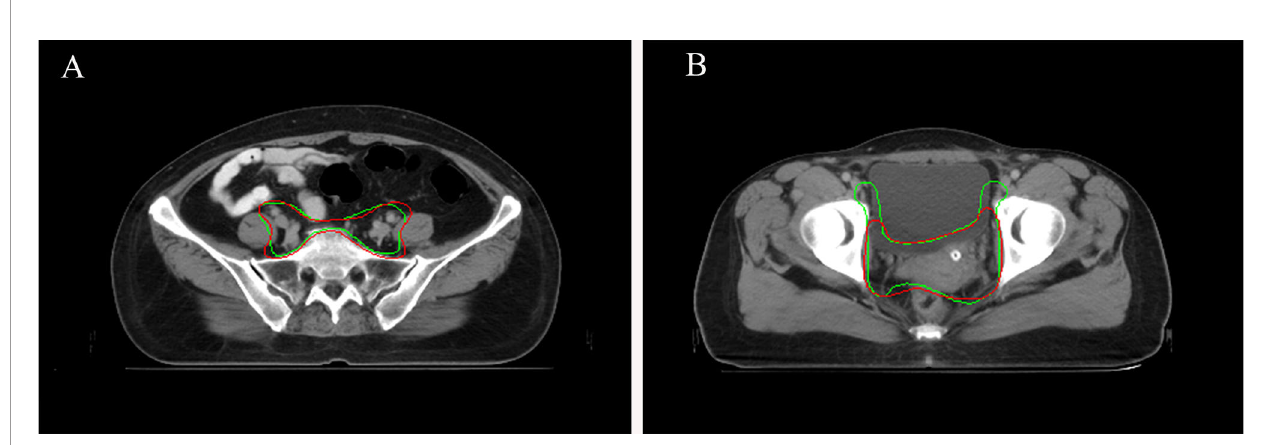
FIGURE 5 | (A) Sample CTV where the AI contour was approved by all the oncologists. AI contours in green line. GT contours in red line. (B) Sample CTV where the GT contour was approved by all the oncologists. AI contours in green line. GT contours in red